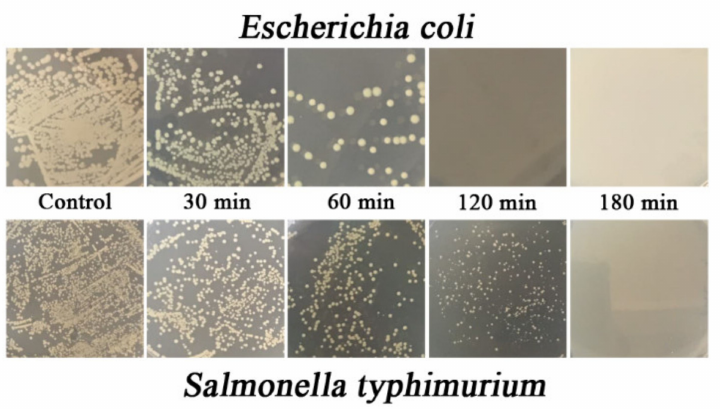
Figure 9. Photographs of agar plate manifestation of E. coli ( top ) and S. typhimurium ( bottom ) under different irradiation